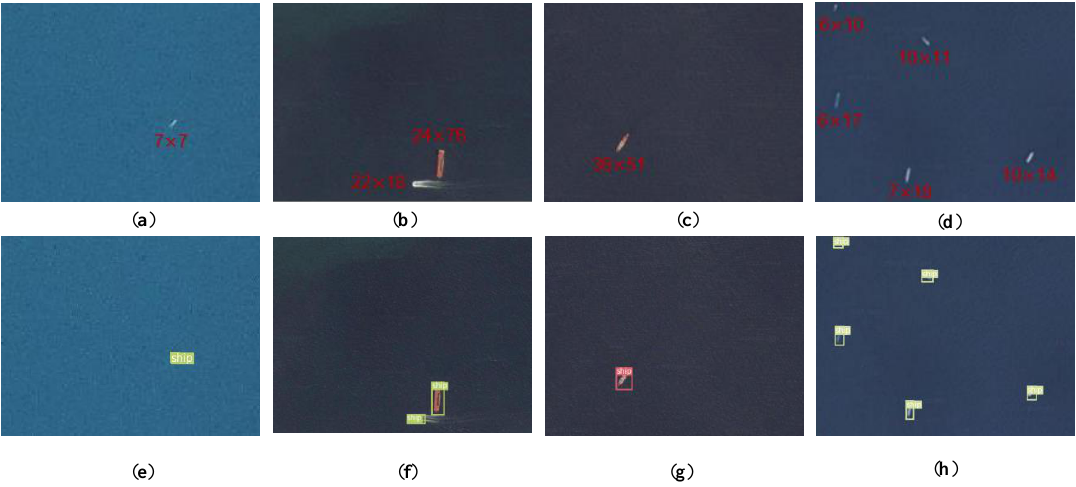
17 of 30 Figure 13. Ship detection results of CFF-SDN model on DSDR dataset. ( a – d ) Ship detection results of visible light images. ( e , f ) Ship detection results of infrared images. ( g – i ) Detection results of ships of different shapes on visible light images. Most of the ships on the sea are small targets, and the CFF-SDN ship detection model is especially designed for the detection of small targets. CFF-SDN uses multi-scale convolution feature fusion, which is very effective for detection of small objects like remote sensing ships. Our model uses the k-means clustering algorithm to cluster the ship sizes of the DSDR dataset, and the number of priori boxes allocated in the network depth information is increased to improve the detection